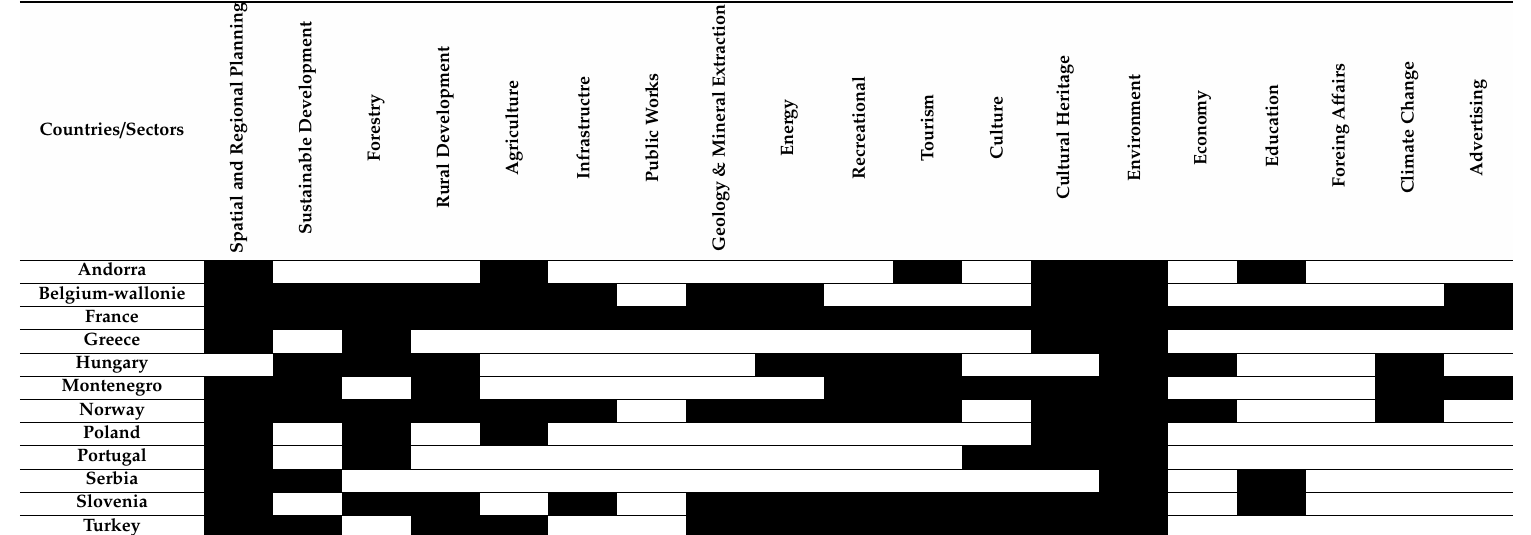
Table 3. Di ff erent policy sectors integrating landscape considerations, in a series of the Council of Europe countries.